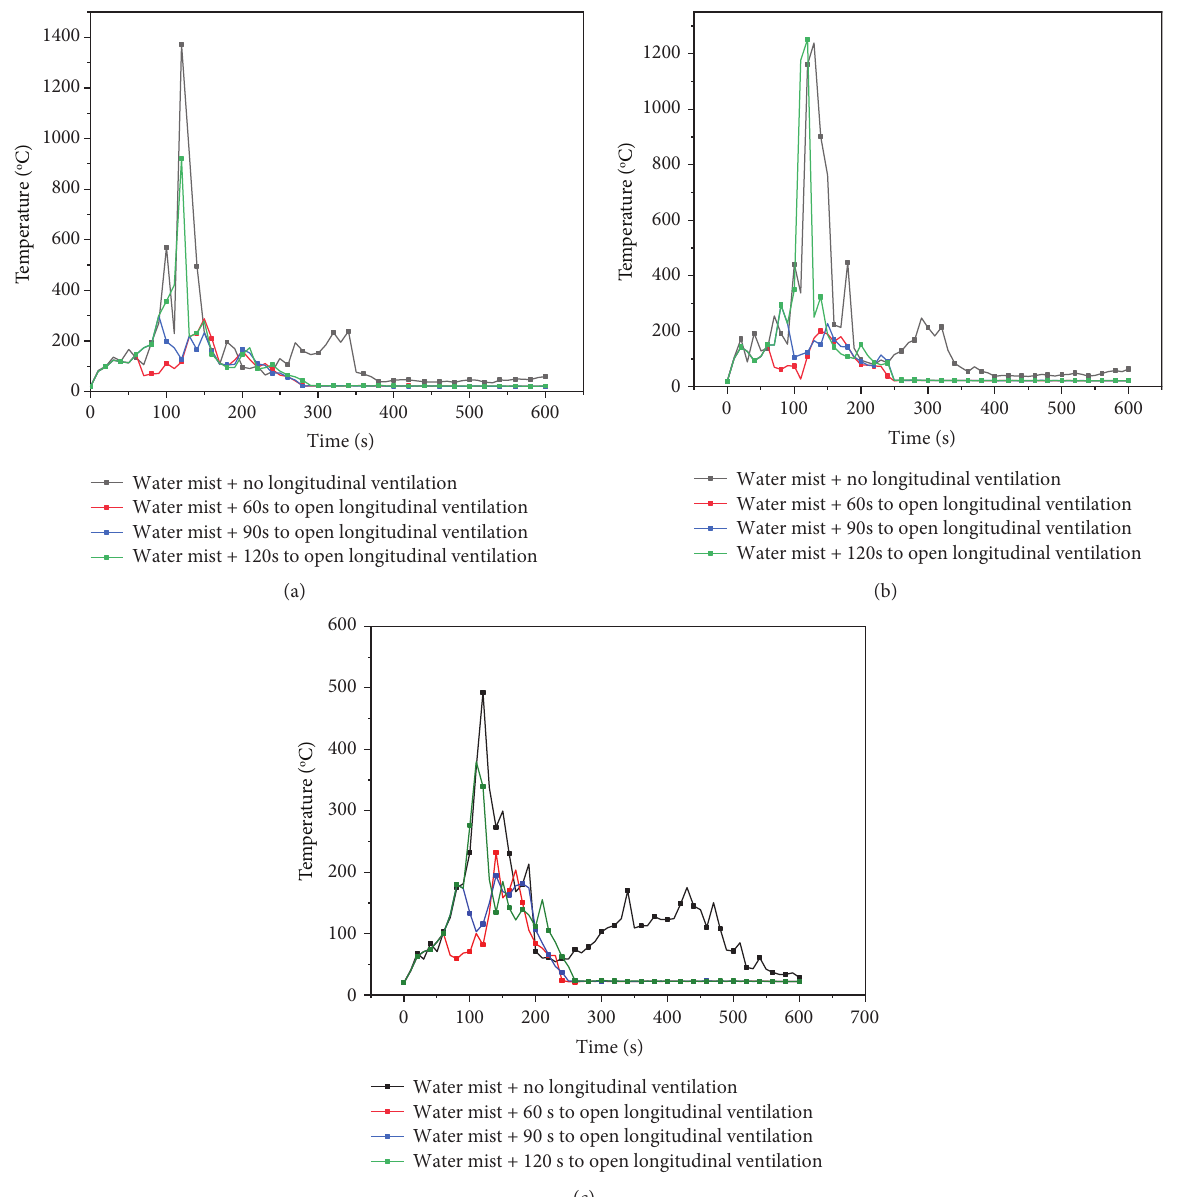
Figure 6: Temperature at vault height under different curvatures. (a) Straight tunnel. (b) Curvature 1/500 tunnel. (c) Curvature 1/860